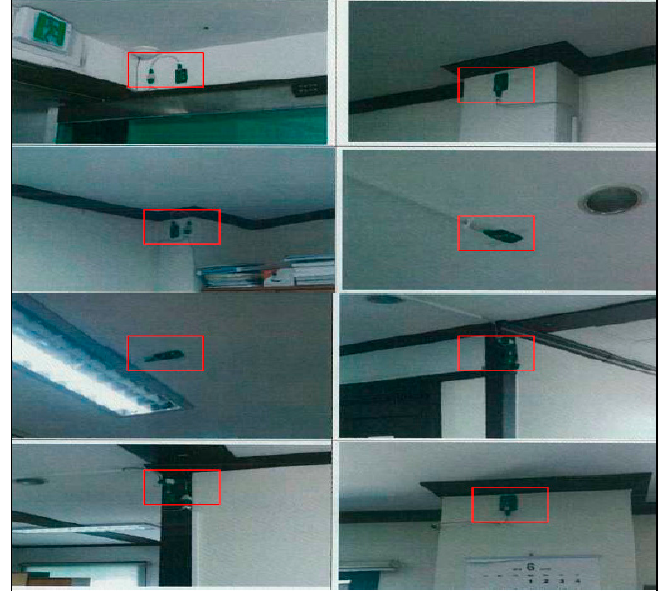
Figure 20. Configuration of test. Table 3. Test item, reference, and their results.